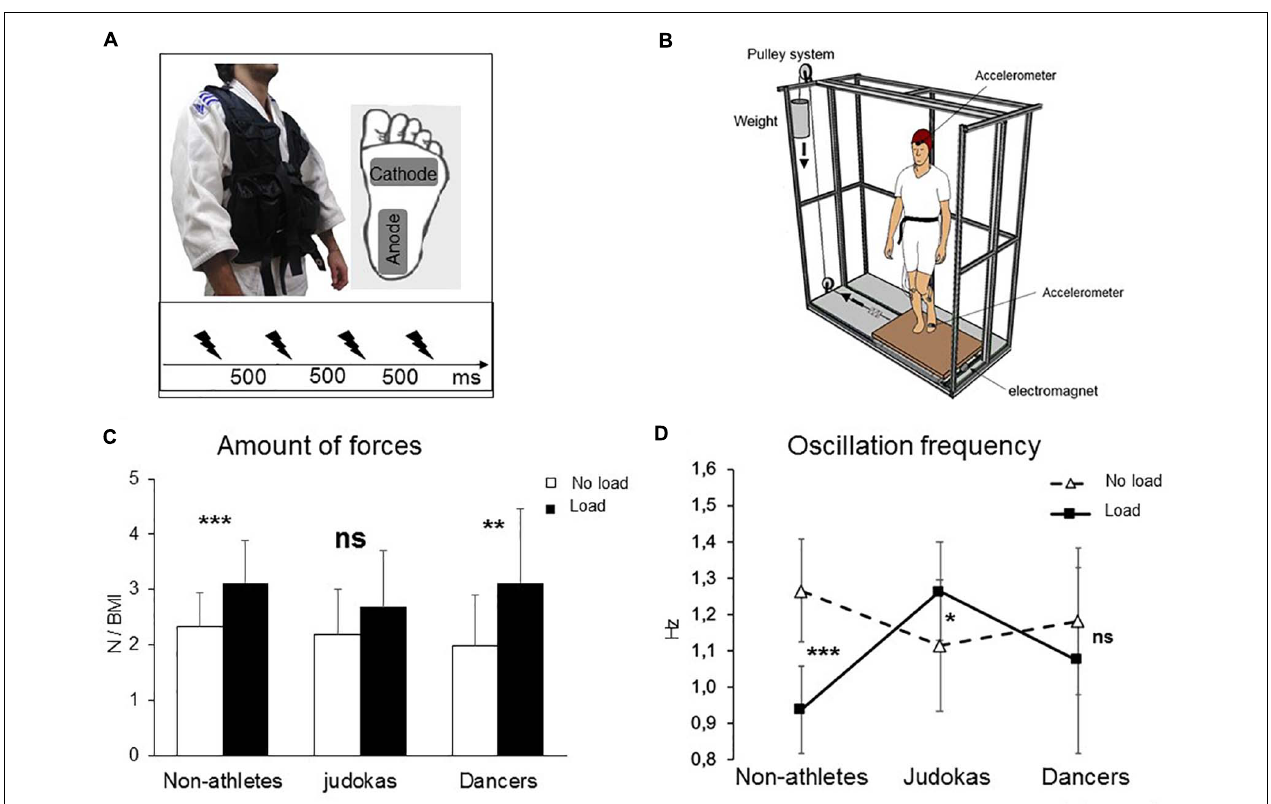
FIGURE 1 | (A) Experimental set up for the electroencephalographic experiment. Insert depicts the workout vest worn by the participants (Judokas, Non-Athletes and Dancers); the added weight was distributed on the front and back of this vest. Position of the stimulation electrodes underneath the left foot and time-intervals between stimulations. (B) Experimental set up for the behavioral perturbation experiment 2. The platform translated to the right participant side by means of a pulley system. (C) Mean integral of the forces in all directions normalized relative to the BMI for Non-Athletes, Judokas and Dancers (error bars are standard deviation across participants) (** p < 0.005; *** p < 0.001 and ns: not significant). (D) Oscillation frequencies for Non-Athletes, Judokas and Dancers (error bars are standard error of the